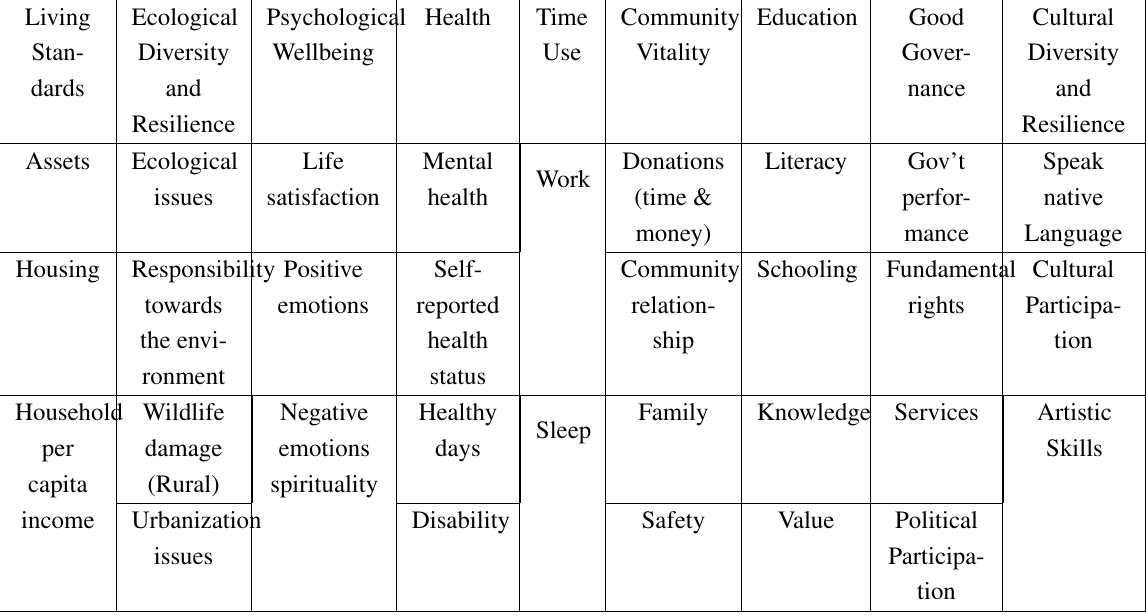
Table 3. GNH classification